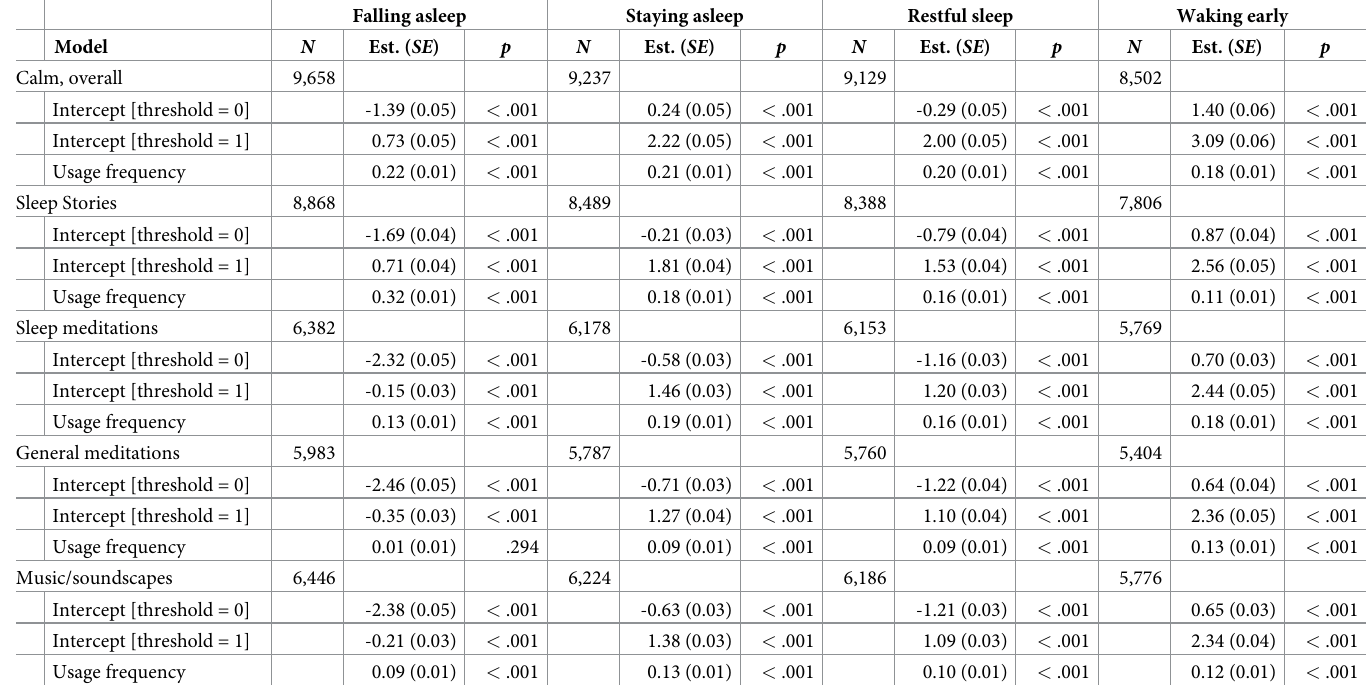
Table 5. Parameter estimates for regressions models of improvements in sleep disturbance based on frequency of using Calm and its components (i.e., Step